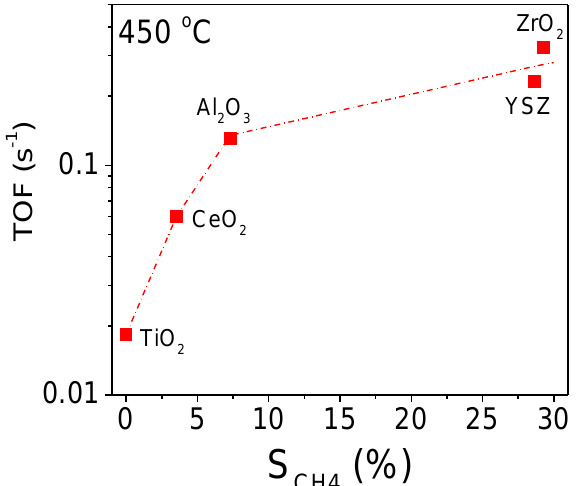
Figure 5. Turnover frequencies of C 3 H 8 conversion as a function of selectivity toward CH 4 obtained at 450 °Cover supported Ni catalysts.